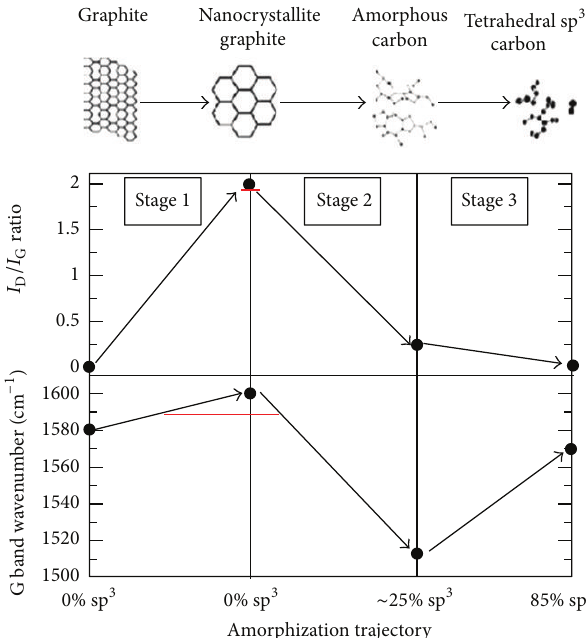
Figure 2: Ferrari-Robertson classification with three stages model.